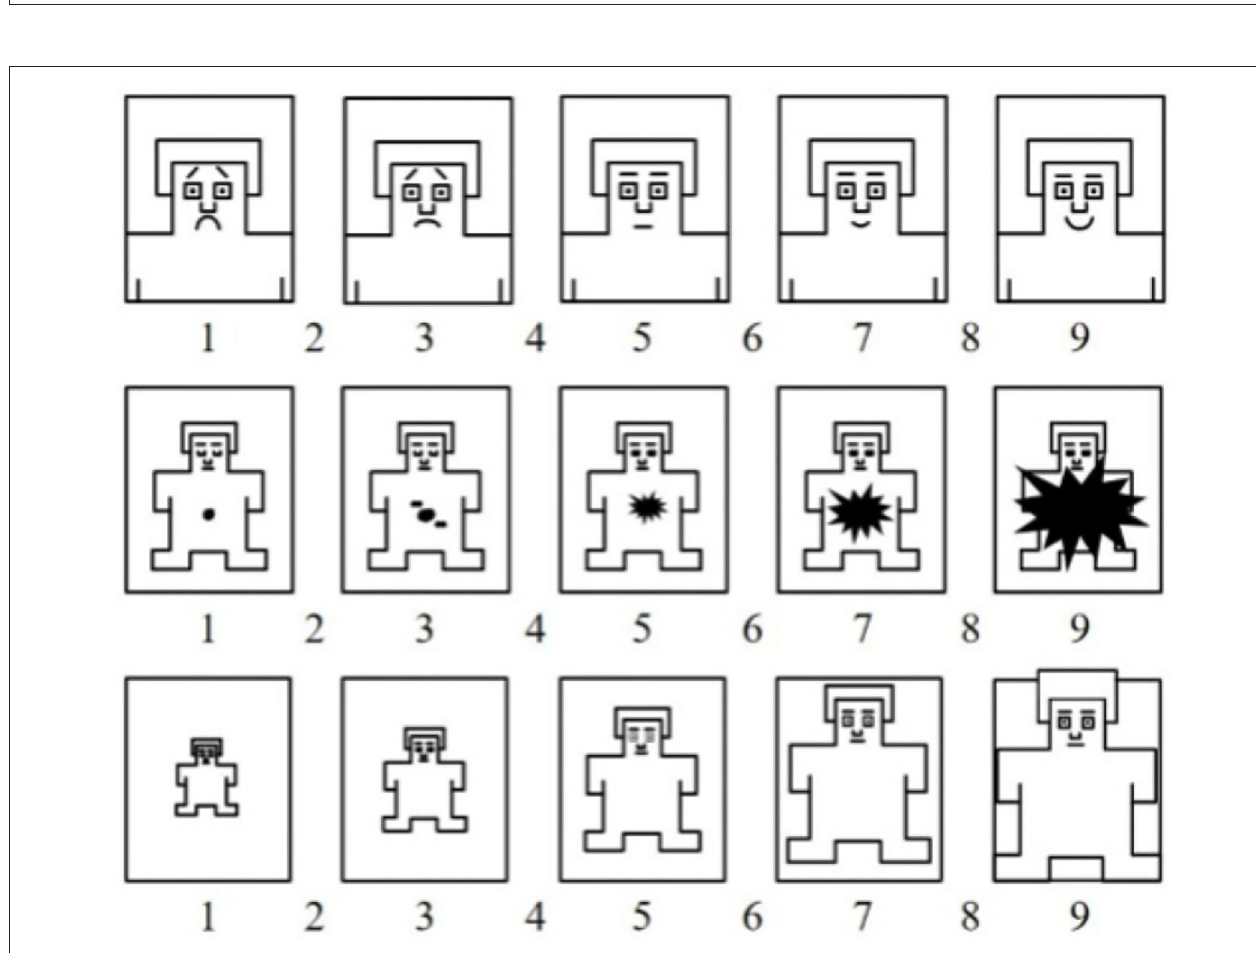
FIGURE 2 | A typical SAM